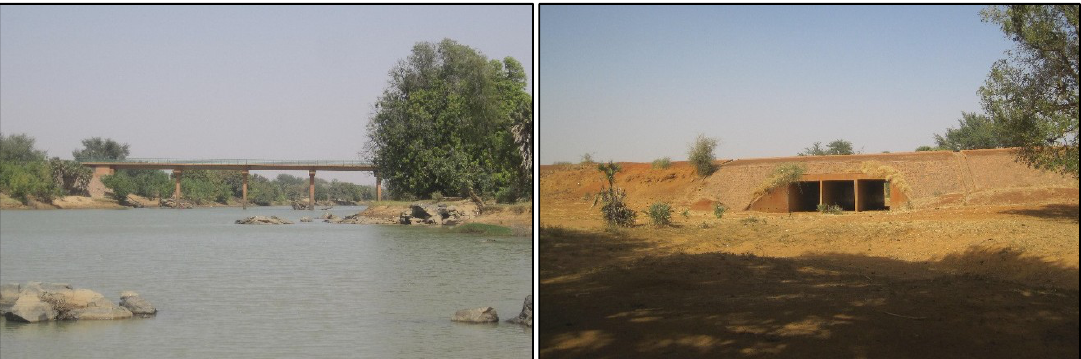
Figure 5. Left: The Farié bridge on the Sirba River. Right: the culvert with three opening placed on the left overbank.